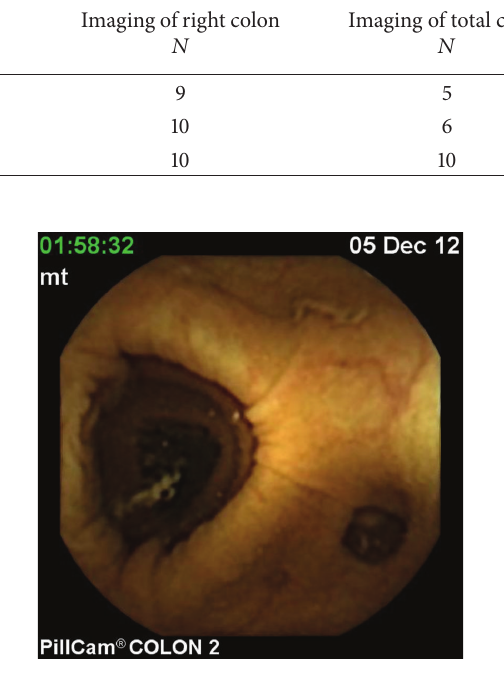
Figure 4: Diverticulosis coli. Table 2: CCE and colonoscopic findings of